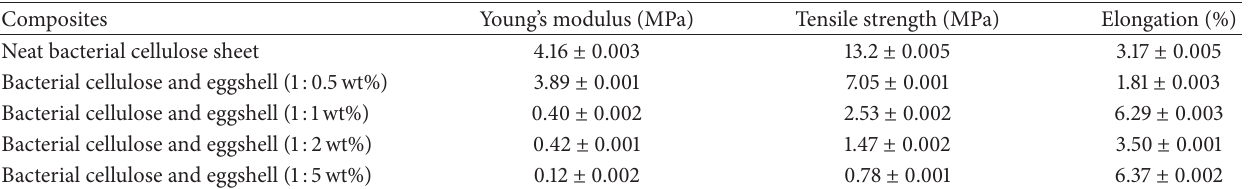
Table 2: Mechanical properties of bacterial cellulose and eggshell composite membrane.